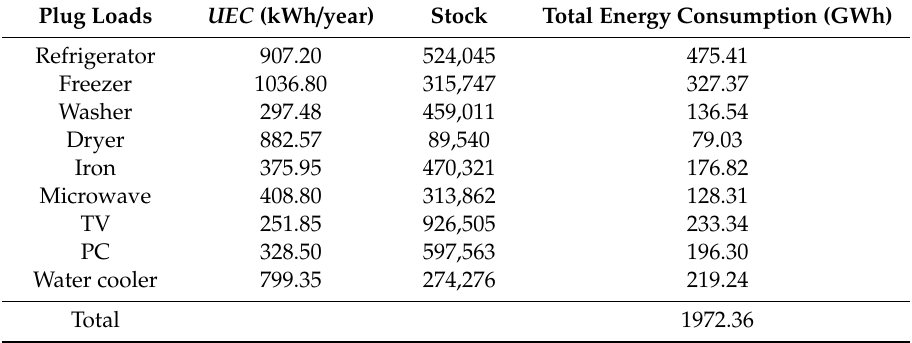
Table 6. The 2017 total energy consumption of the modeled household appliances with corresponding stock quantities for Kuwaiti residential homes (2017).